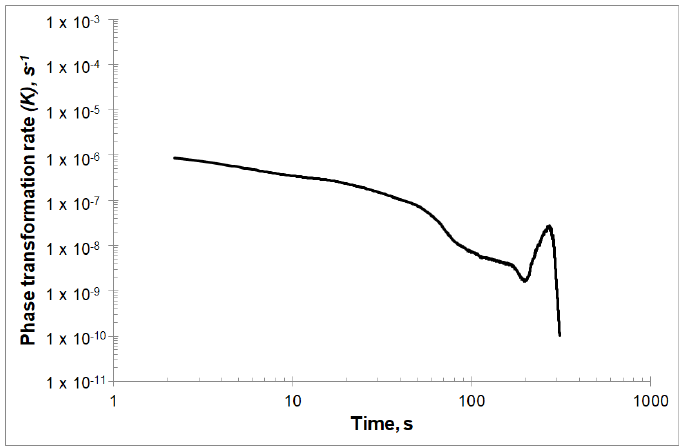
Figure 4. The phase transformation rate K varied with time t for isothermal annealing temperature equal to 507 K. equal to 507